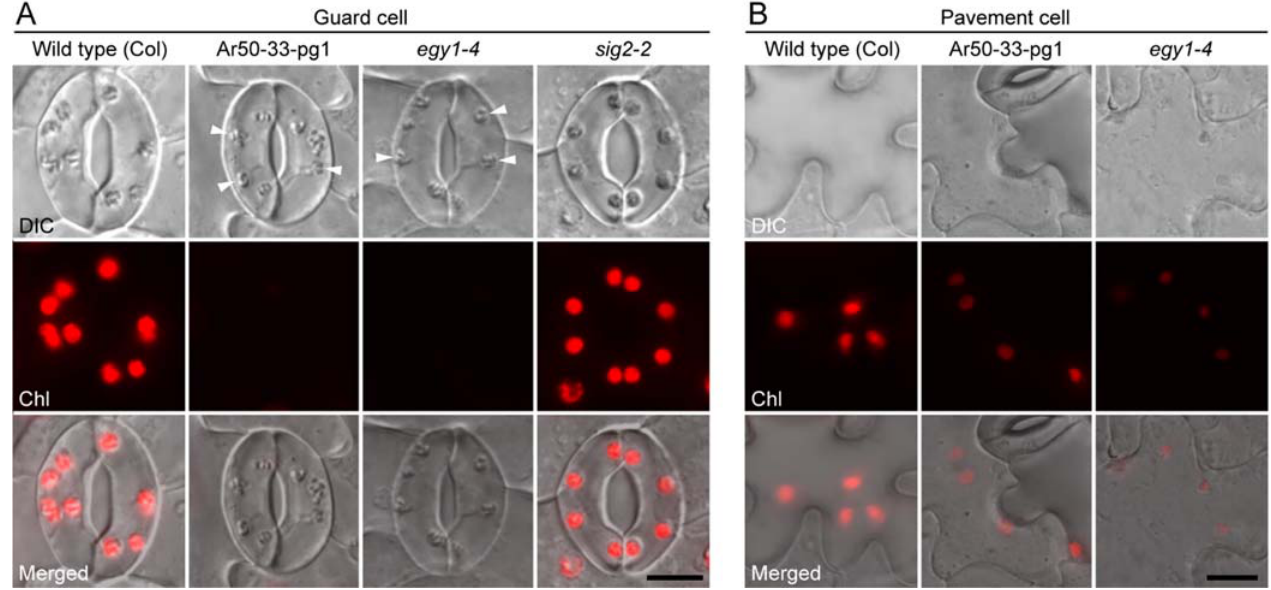
Figure 2. Fluorescence microscopy of the epidermis of expanding wild-type and mutant leaves. ( A , B ) DIC, chlorophyll autofluorescence (Chl), and merged images of guard cells ( A ) and pavement cells ( B ) in the abaxial leaf epidermal peels of the third and fourth leaves of 2-week-old seedlings. Arrowheads indicate putative chloroplasts or plastids. Bar = 10 µ